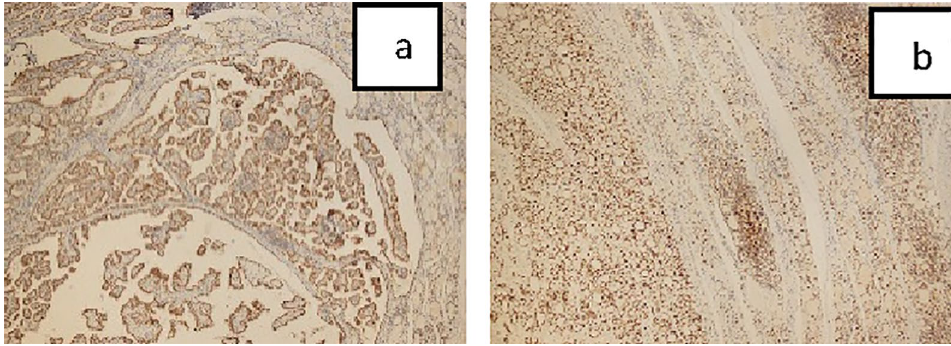
Figure 2. ( a ) MSH2 immunoreactivity PTC (× 4). ( b ) MSH2 immunoreactivity Chronic thyroiditis (× 4).